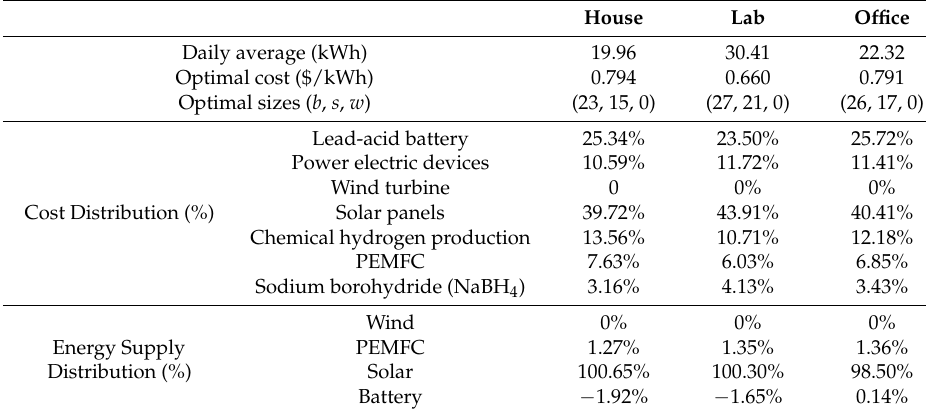
Table 8. Cost and energy distributions for the optimal